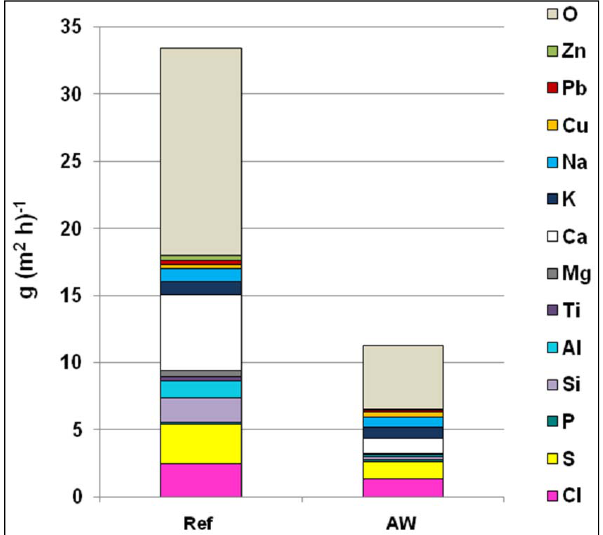
Figure 5. Deposition growth rate and elemental analysis for the Ref and AW